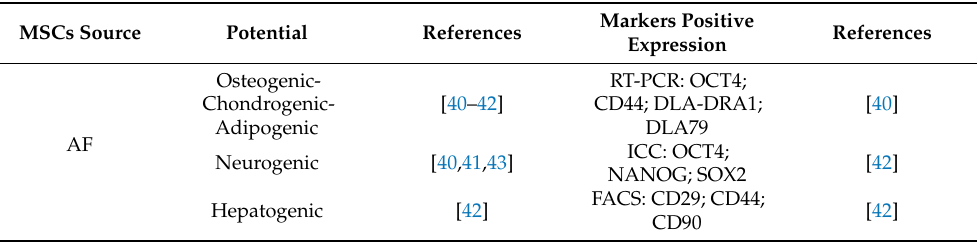
Table 1. Canine foetal fluid and adnexa derived mesenchymal stem cells: potential differentiation in vitro and molecular